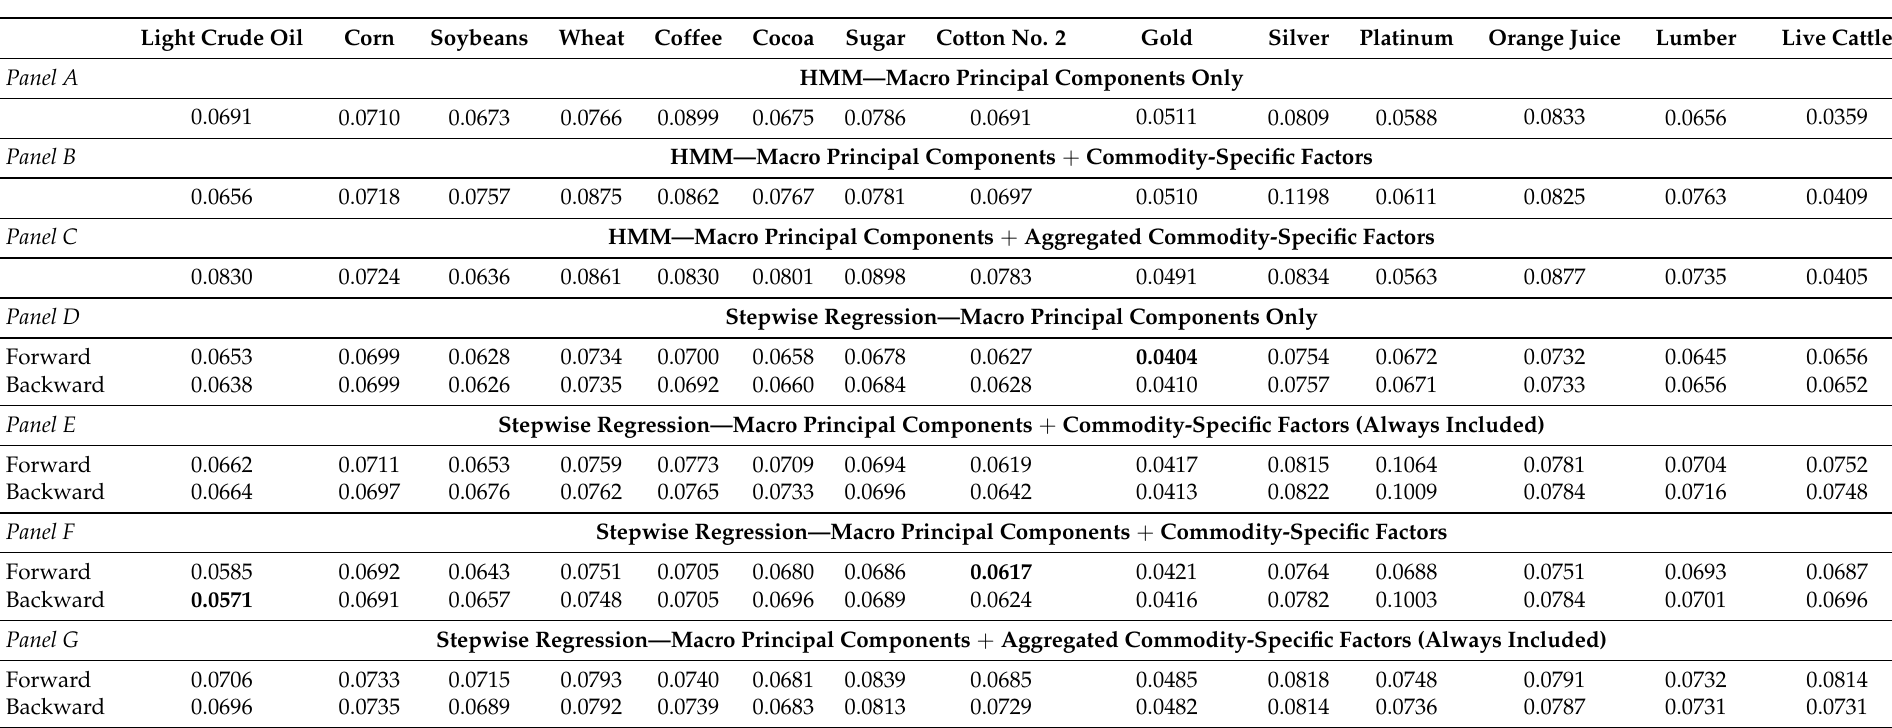
Table 4. Mean absolute error forecast performances—hidden Markov chain vs. stepwise regression models. The table reports the MAFE implied by the